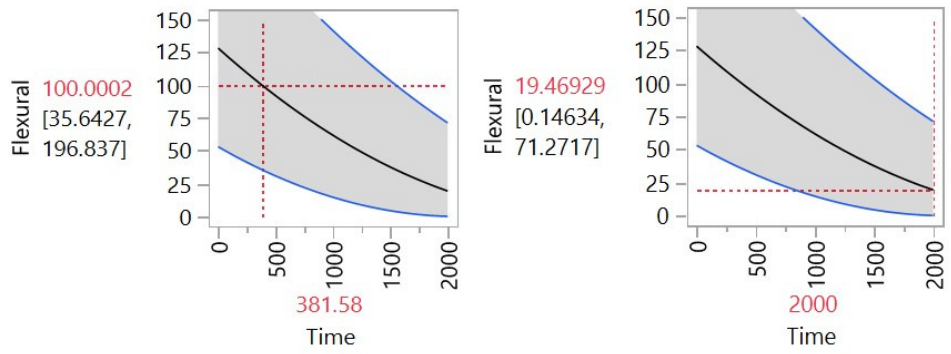
Figure 5. Degradation predictions: